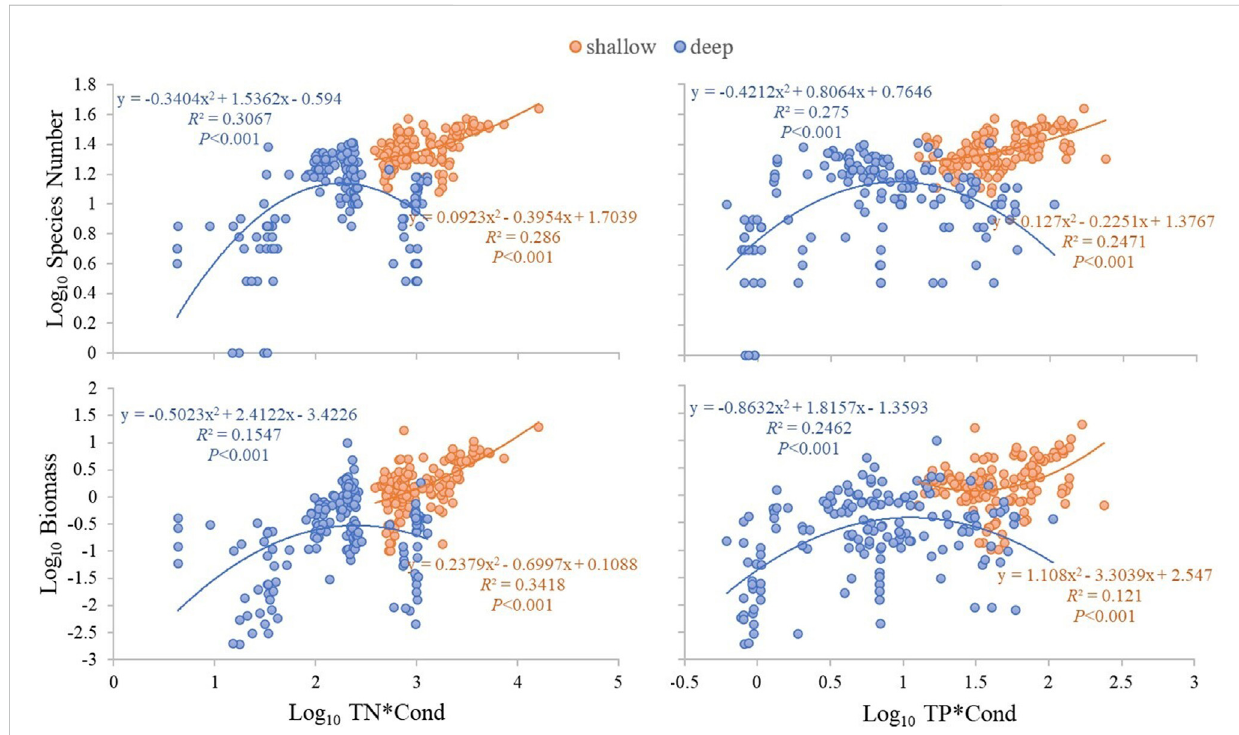
Second-orderpolynomialanalysisoftherelationshipbetweenTN*CondandTP*Condandzooplanktonspeciesnumberandbiomassinthestudied